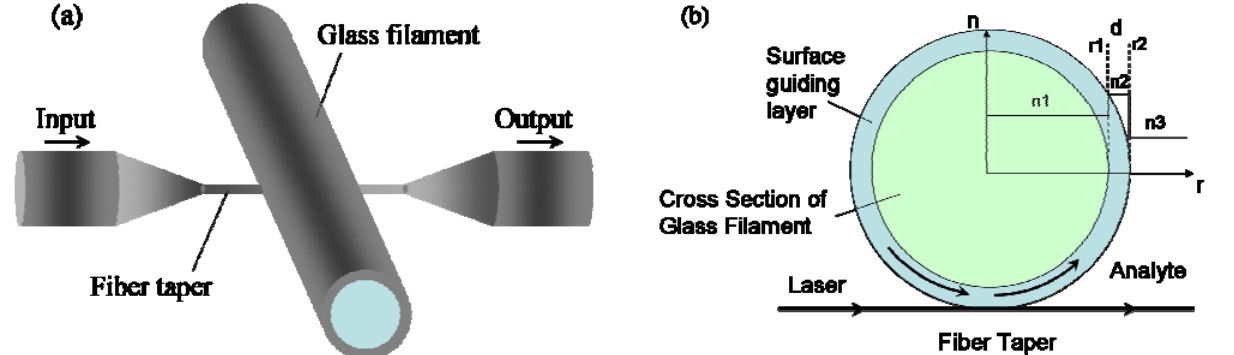
Figure 1. (a) Schematic illustration of the proposed sensor structure. (b) Cross section of the glass filament coupled by a fiber taper, r surface guiding layer, n layer and analyte medium